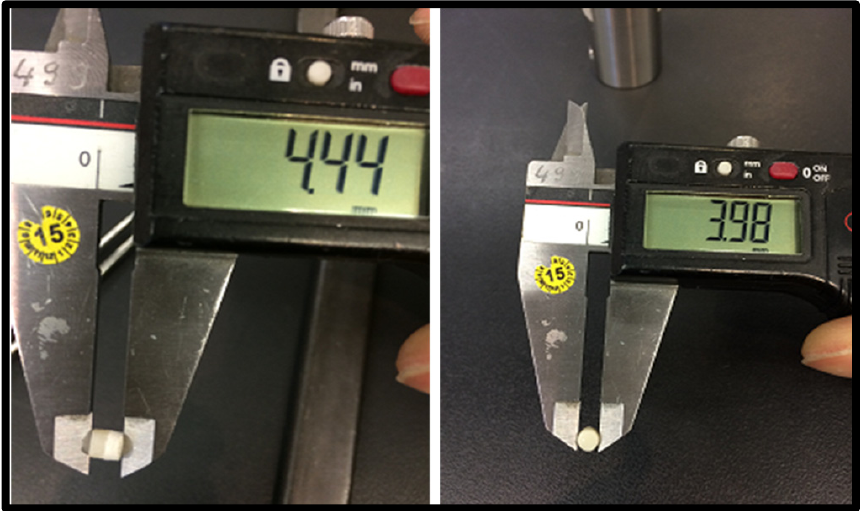
Figure 2. Calibration of the prepared restorative material samples. Step 3: The UTM with a special clamping device to simulate 90-degree shear testing specimen on one side was utilized for gripping,